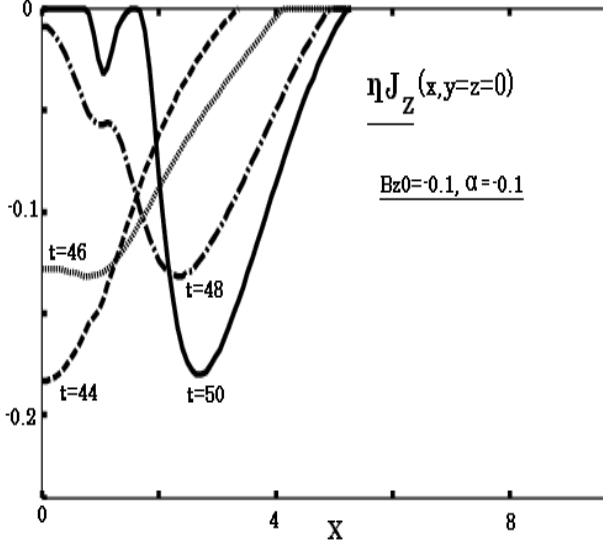
z ( r = 0) Fig. 3. Profiles of ηJ z along the x-axis for the case of B z 0 = − 0 . 1 and α =− 0 . 1 at different Figure 3: Proflles of ·J along the x axis for the case of z B = 0 : 1 and fi = 0 : 1 at difierent times. z 0 ¡ ¡